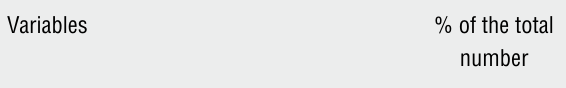
Table 1 - Characteristics of 72 patients at the entry to the